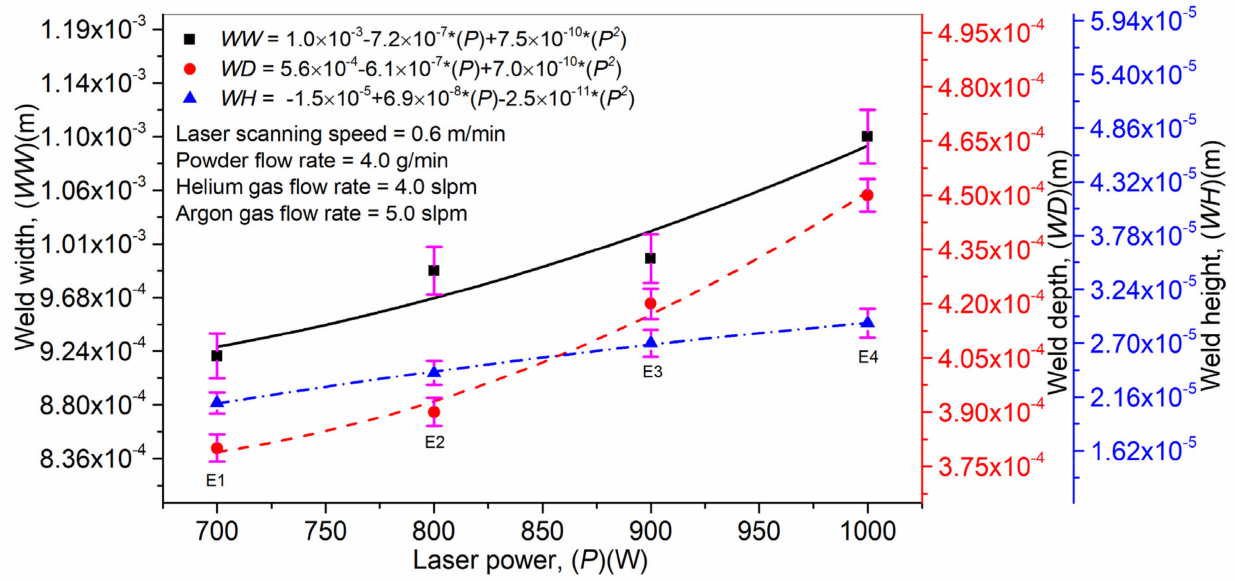
Figure 9. Effect of laser power on laser weld width, depth, and height in laser welding with filler material (Inconel